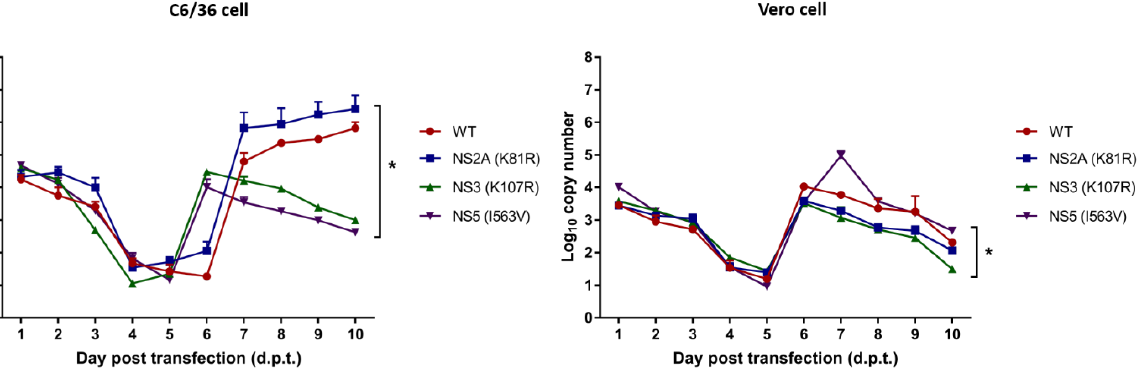
Figure 3. Infectivity of infectious clones containing genome length RNA of wild type (WT), NS2A (K81R), NS3 (K107R), and NS5 (I563V) mutants in C6/36 cells and Vero cells. The viral copy numbers were measured from culture supernatants by RT-qPCR at 1 to 10 d.p.t. Results are expressed as the mean and SD of triplicate experiments. Statistically significant differences between each group are indicated by * p < 0.05 (one-way ANOVA with multiple comparisons, Tukey’s post-test).